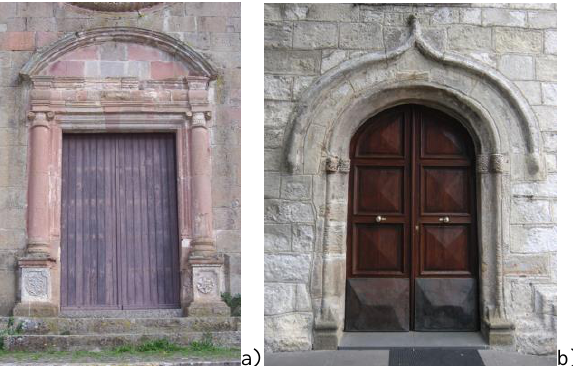
Figure 3. Example of portals: a) lintel (influenced by Italian Renaissance), San Mauro, Sorgono (Nu); b) arch with three centers and “flame arch”, San Vincenzo, Orroli